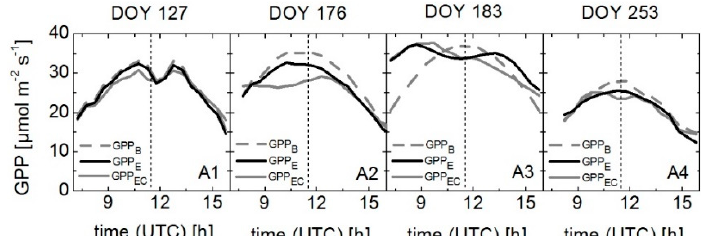
Figure 7. Diurnal behavior of gross primary productivity (GPP) derived from the eddy covariance (EC) method (GPP EC ) and GPP calculated using two different approaches (GPP B and GPP E ) for winter wheat (DOY 127, 176) and for sugar beet (DOY 183, 253). Other model runs (GPP A , GPP C and GPP D ) are also available and results of the improvement are presented in Figure 8.